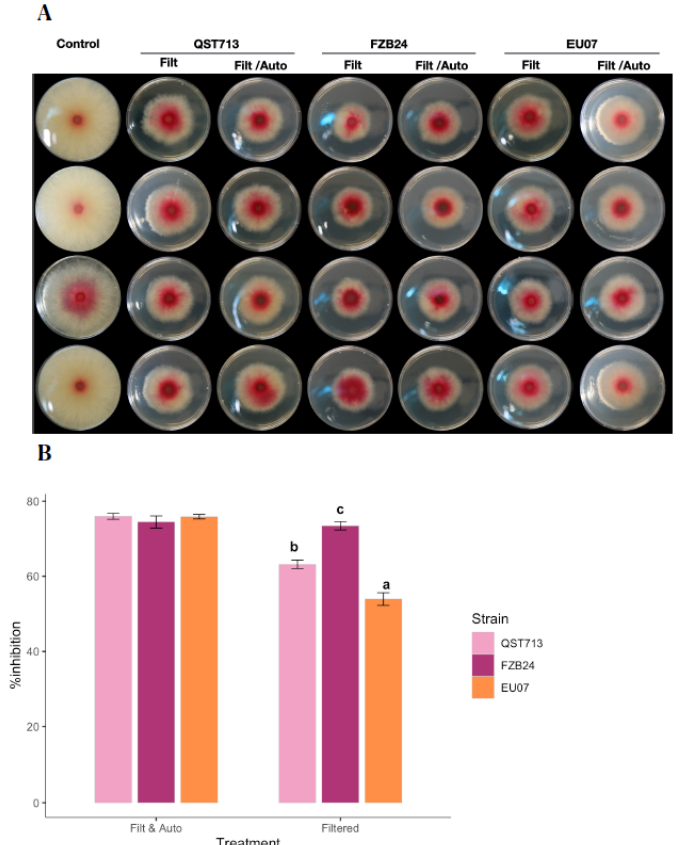
Figure 3. Inhibition assay with filtered unautoclaved or autoclaved bacterial broths. ( A ) Antagonism assays using filtered, autoclaved or unautoclaved broths. Bacterial broths were obtained from 24 h bacterial cultures, filtered, adjusted to 100 µg/mL and autoclaved. Bacterial broths are shown by bacterial treatment (top, left to right) and by type of treatment only filtered -Filt- and filtered/autoclaved -Filt/Auto- (top, left to right). ( B ) Percentage inhibition of the Fg -K1-4 by Bacillus broths that were filtered, adjusted and autoclaved. Antagonistic effect of the Bacillus strains (QST713, FZB24 and EU07) against Fg- K1-4 in % inhibition and broths adjusted (1.0 µg/mL). In general, the autoclaved treatments displayed a higher % inhibition with a little variability within Bacillus strains. Data were from one independent experiment of four repeats and shown as the mean ± SE. Experiments were replicated twice with similar results. Bars with different letters indicate significant difference according to Tukey’s Test ( α < 0.05) following two-way ANOVA. n =